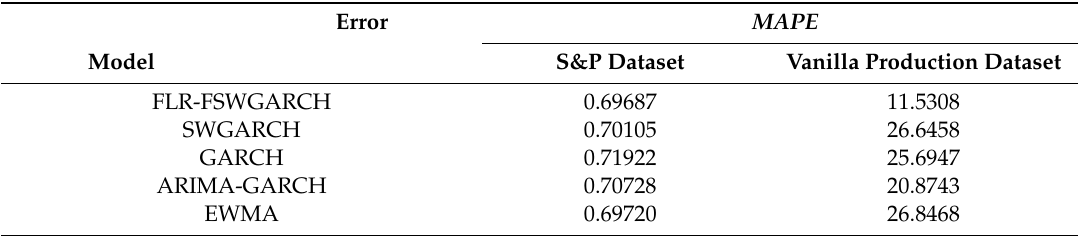
Table 5. Mean absolute percentage error ( MAPE ) of the datasets for di ff erent models.